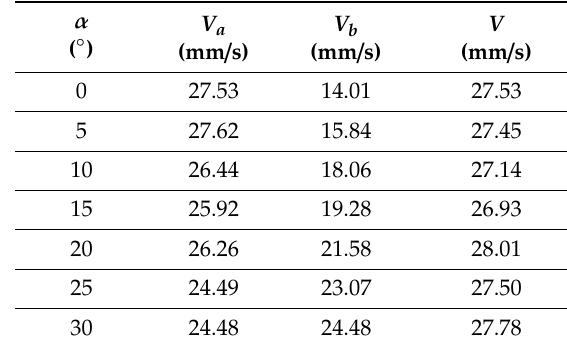
Table 1. Direction angle α and velocity data of V a , V b and V .